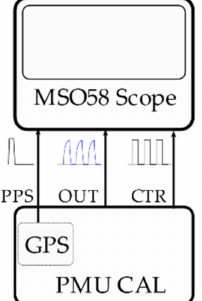
Figure 3. Schematics of the calibrator synchronization